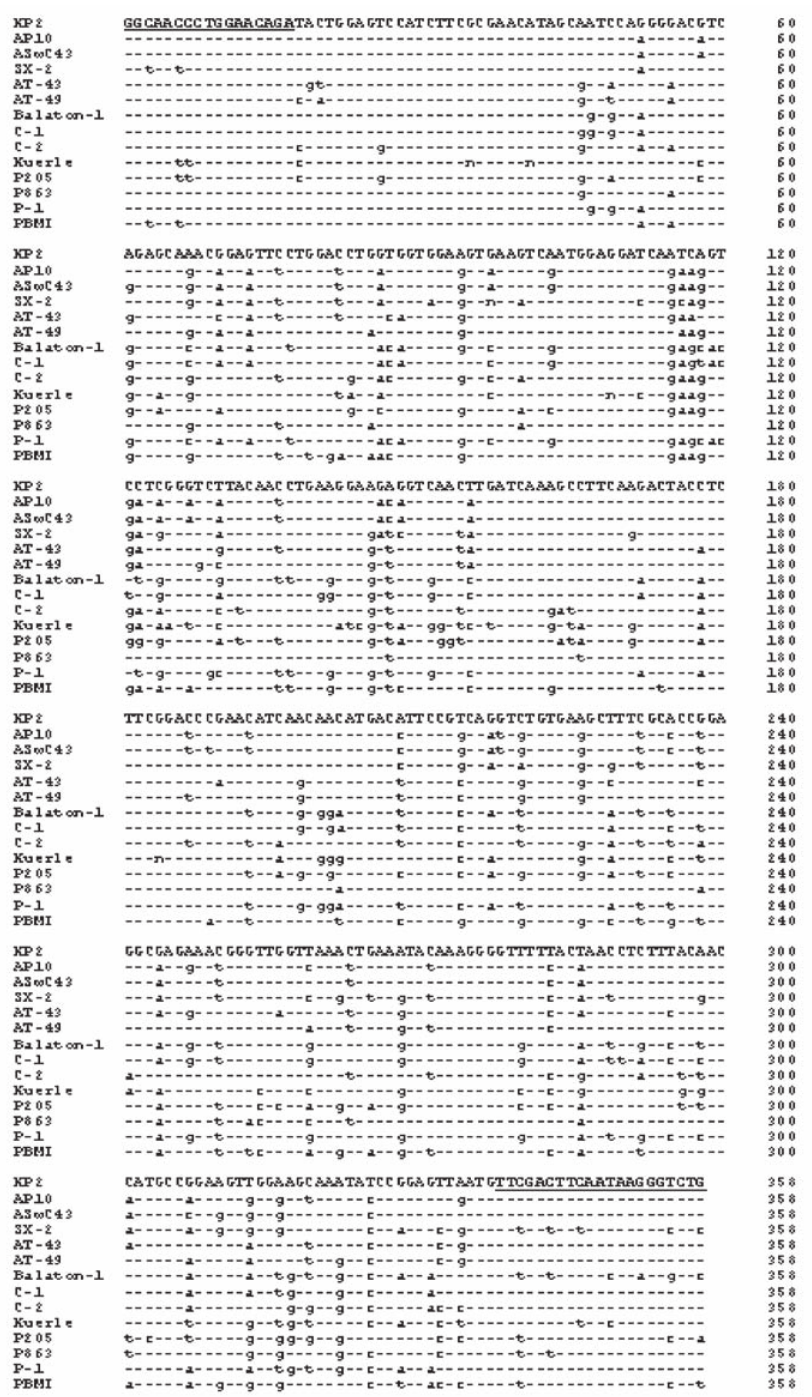
Fig. 2. Multiple nucleotide sequence alignment of Apple chlorotic leaf spot virus isolates based on the 3’-end region of the 50 kDa and 28 kDa proteins of the overlapping ORF. Dashes indicate conserved nucleotides. The upper underlined sequence represents the A53 primer, the lower one, the A52